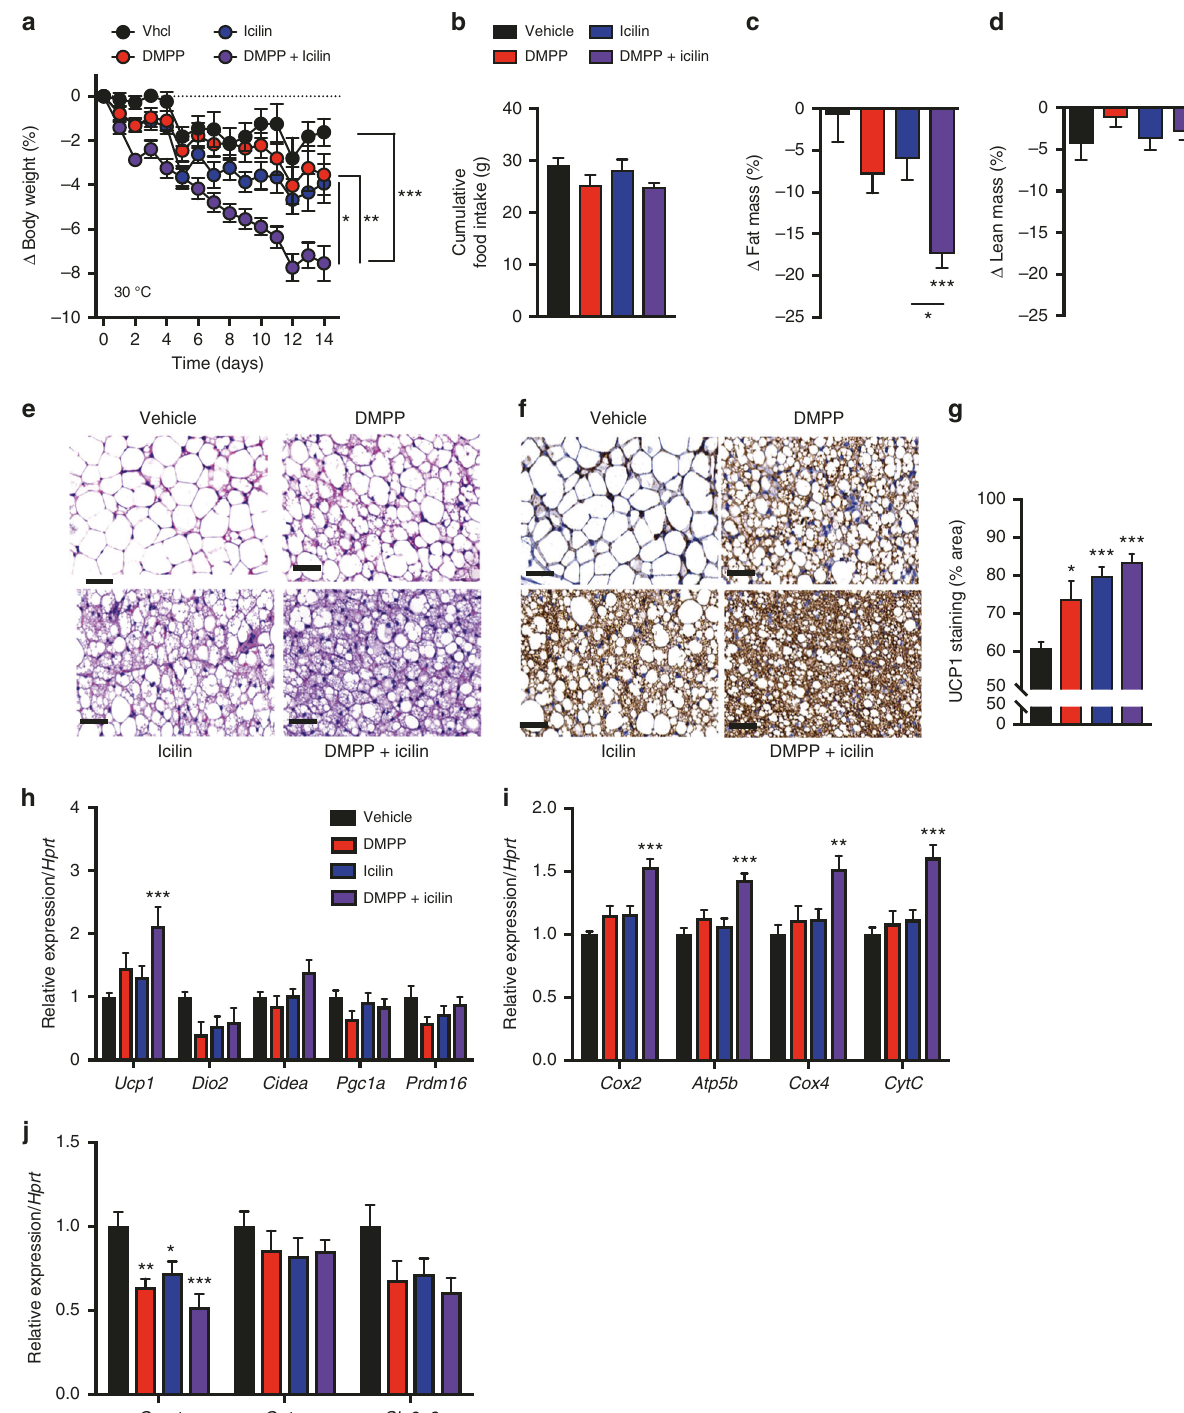
Fig. 5 Icilin and DMPP reverse obesity and increase BAT UCP1 at thermoneutral conditions. a Effects on body weight, b cumulative food intake, changes in c fat mass and d lean mass, e BAT H & E staining, and f UCP1 immunoreactivity staining in BAT with g quanti fi cation of UCP1 immunoreactivity staining (% area). BAT expression of genes involved in h thermogenesis, i mitochondrial transport, and j creatine signaling pathway following daily s.c. injections of vehicle (black or white, n = 8), DMPP 5 mg/kg (red, n = 7), icilin 5 mg/kg (blue, n = 8), or the combination of DMPP 5 mg/kg and icilin 5 mg/kg (purple, n = 7) to DIO male C57Bl6j chronically housed at 30 °C for 14 days. All scale bars are 50 µ m. * p < 0.05, ** p < 0.01, *** p < 0.001 by two-way ANOVA ( a ) and one-way ANOVA ( b , c , d , g , h , i , j ) with Tukey post-hoc test. All data are presented as mean ±